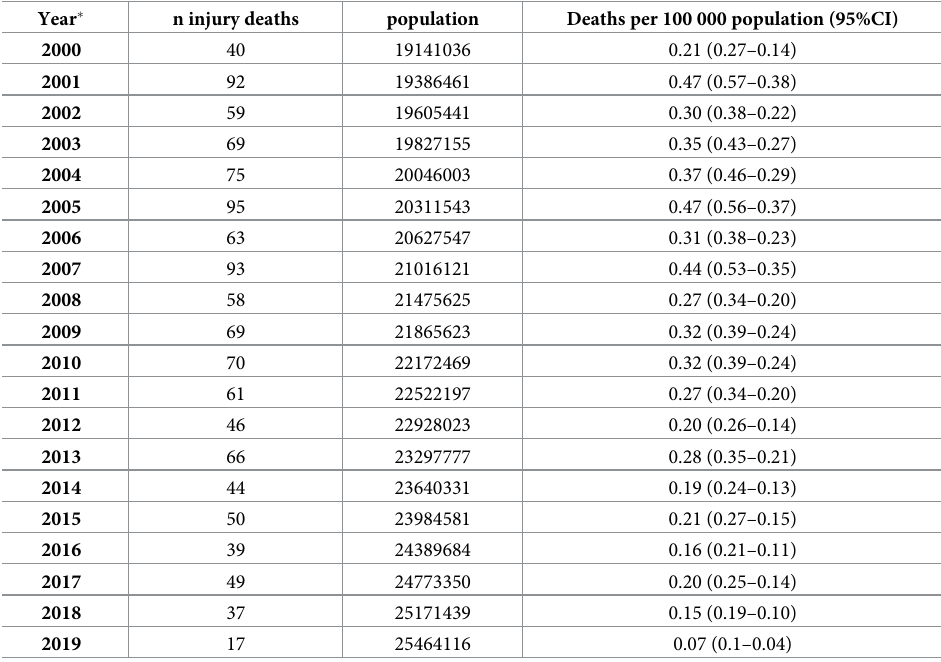
Table 3. Number of injury deaths in Australian sport and recreation from 2000 to 2019, incidence rate per 100 000 population with 95% confidence interval (n =